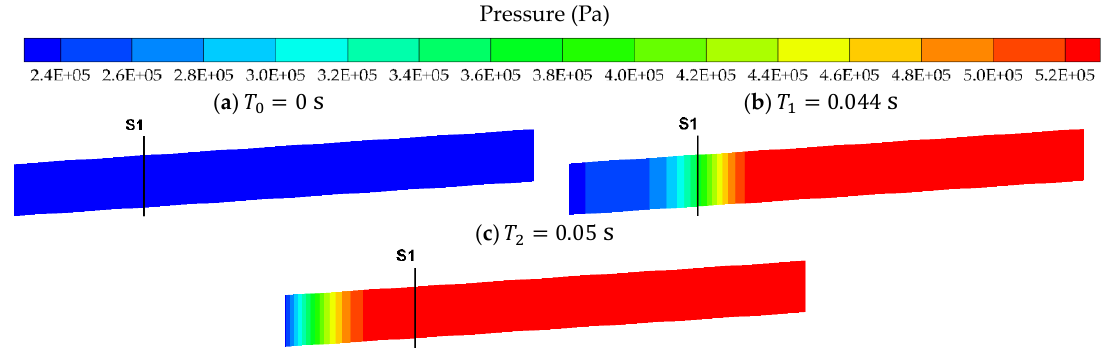
Figure 12. Pressure field evolution on the axis plane of the pipeline ( 𝑇 0 = 0 s , 𝑇 1 = 0.044 s , and 𝑇 2 = 0.05 s ).